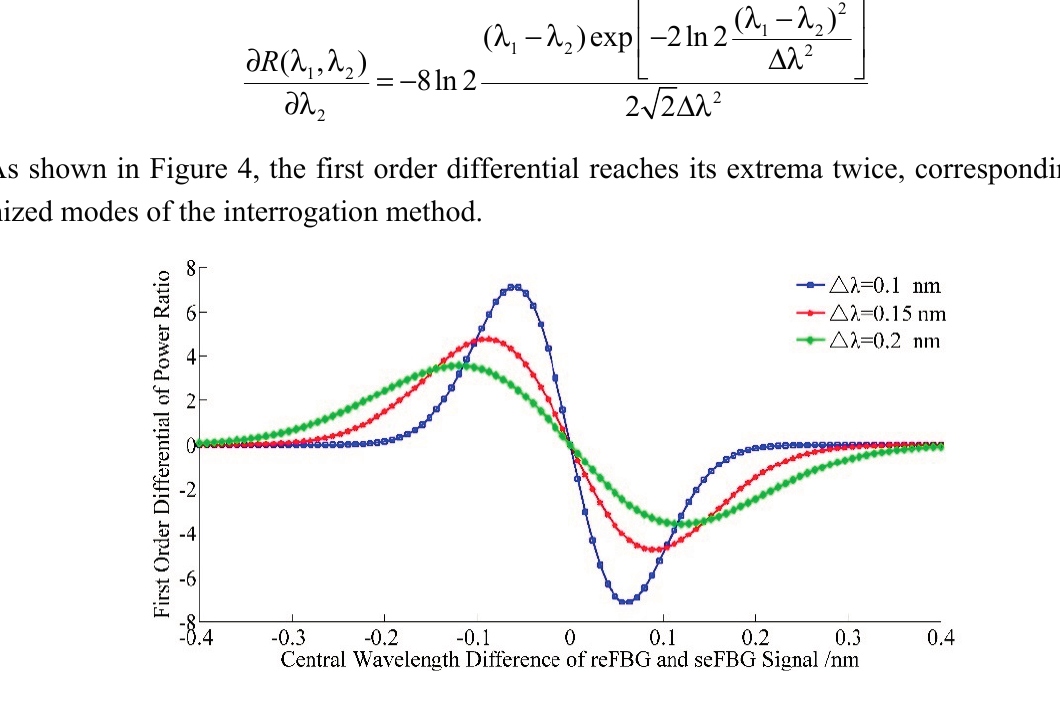
Figure 4. Relation between the first order differential of the power ratio and central wavelength difference between the reFBG and